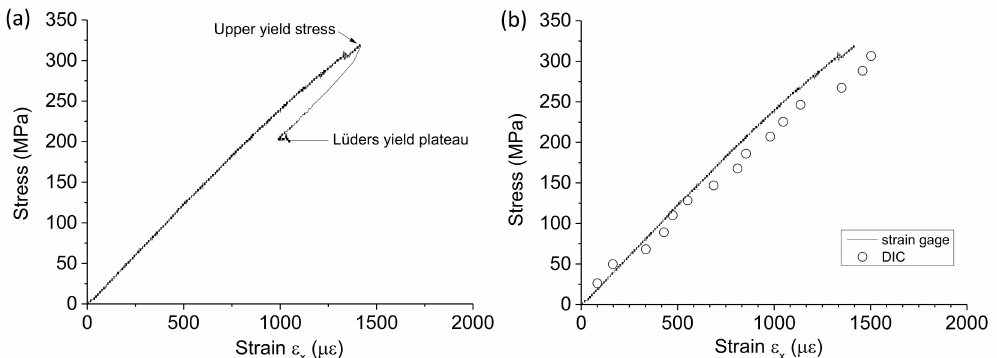
Figure 5. ( a ) Global stress–strain curve; ( b ) stress–strain curve in the macroscopic elastic region. Solid curve was measured by strain gage. represents the average strain of the two-dimensional strain (cid:35) contours obtained by DIC.